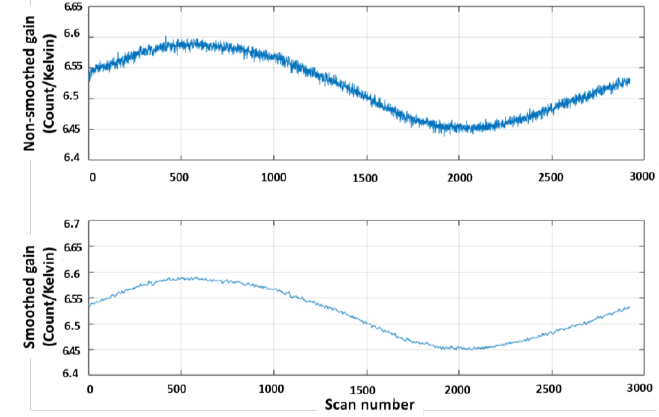
Figure 2. Smoothed ( bottom panel ) and non-smoothed ( upper panel ) calculated gain for channel 10.65 V and orbit # 92412. 10.65 V and orbit # 92412. 10.65 V and orbit #